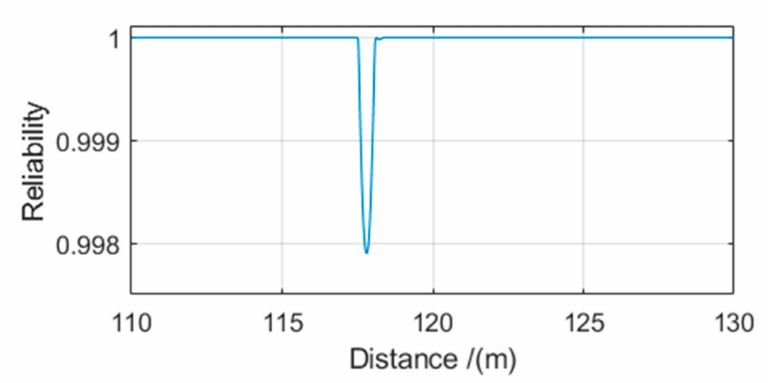
Figure 11. Equiprobability curve of reduction rate of wheel-load when up-arch is 12 mm.